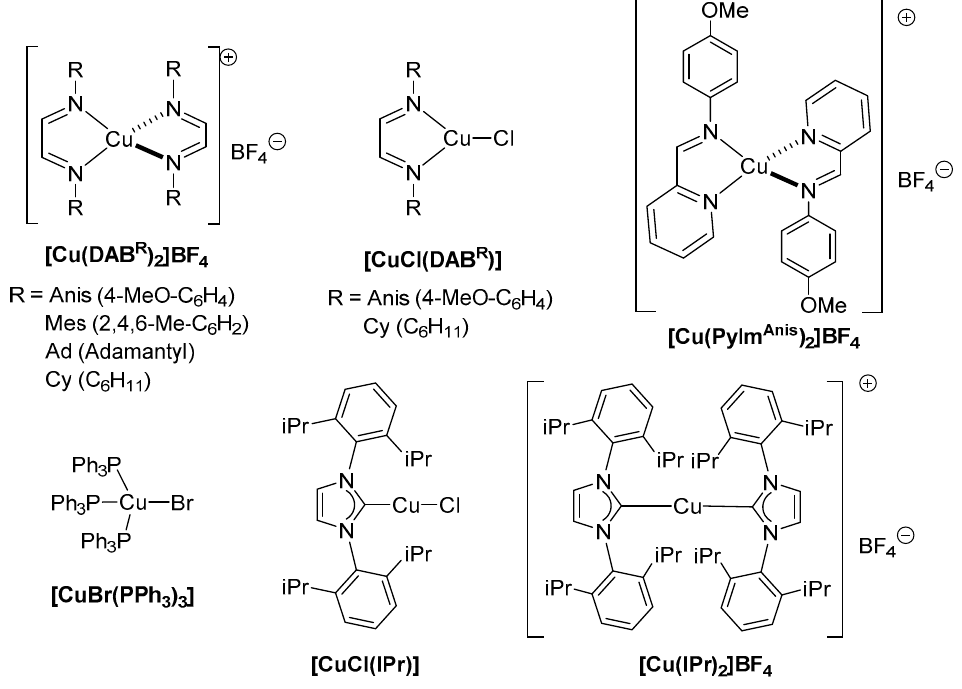
Figure 1. Copper(I) complexes screened in this work. Catalysts with DAB, pyridylimine (PyIm), phosphine or N-heterocyclic carbenes ligands were screened with 1-octyne as model substrate in technical deuterated acetone in the presence of air (Table 1).